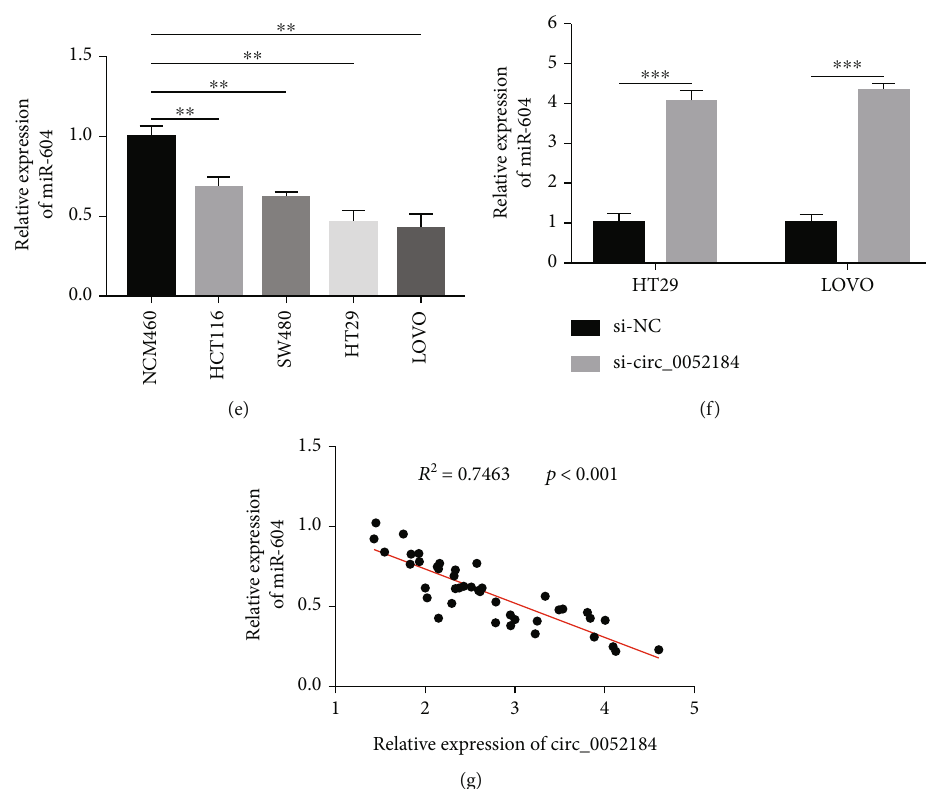
Figure 3: miR-604 is a downstream target of circ_0052184. (a) Bioinformatics was used to predict the complementary sequence between miR-604 and circ_0052184 by circinteractome. (b, c) Dual-luciferase reporter assay (b) and RIP assay (c) were used to verify the binding relationship between miR-604 and circ_0052184. (d, e) qRT-PCR was used to detect the expression of miR-604 in CRC tissues and cell lines. (f) qRT-PCR was used to measure miR-604 expression in LoVo and HT29 after circ_0052184 inhibition. (g) Pearson correlation between miR-604 and circ_0052184 in CRC tissues. ∗ p < 0 : 05 , ∗∗ p < 0 : 01 , ∗∗∗ p < 0 : 001